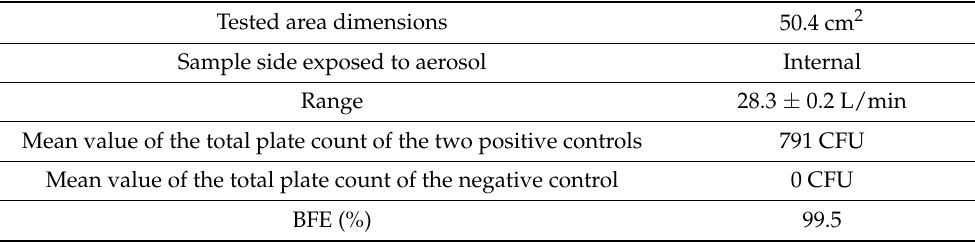
Table 6. Individual BFE values of FFP2 E. All samples exceeded the breathability and bacterial filtration tests (BFE). A BFE value greater than or equal to 98% was found on all samples, as required by the UNI EN 14683: 2019 + AC: 2019 standard.